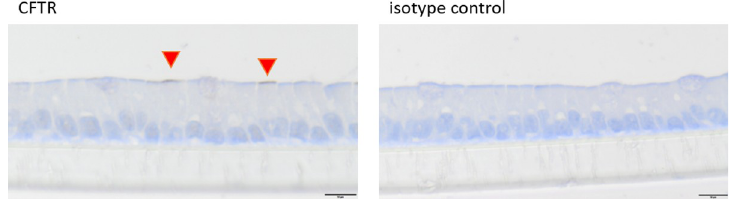
Fig 6. Cellular arrangement (cross sections) of jejunum organoids grown in 2D on Snapwells 1 for 18 days. Immunohistochemical staining (including isotype controls) of CFTR was performed. Red triangles indicate cells with a positive signal of CFTR. Representative figures are shown, chosen from three independent experiments with three technical replicates per